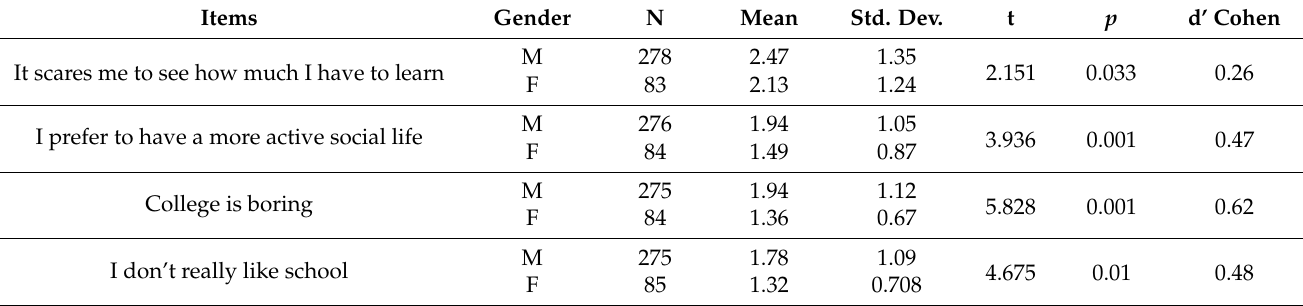
Table 3. Gender differences regarding the perceived barriers to the completion of university studies.